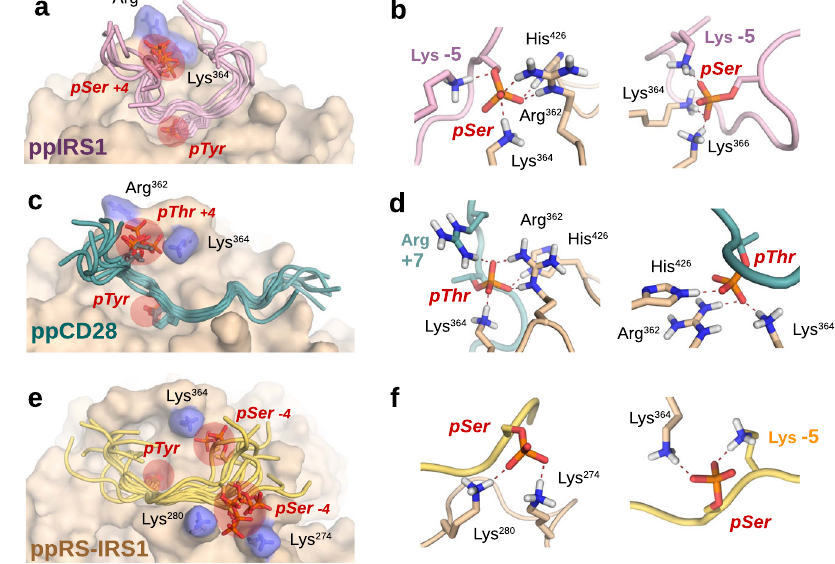
Fig. 5 | Haddock modelling of all three SHP2-substrate complexes. Structural ensembles from the lowest energy HaddockclustersobtainedfortheSHP2-ppIRS1 ( a ), SHP2-ppCD28 ( c ) and SHP2-ppSRev-IRS1 ( e ) complexes after docking a 20- state, structurally diverse input fi le for each structure. The three ensembles are shown from similar angles, providing visibility to the phosphate groups. Residues coloured in blue represent key pSer/pThr coordination points (the two phosphate groups are highlighedinred). PolarH-bondsare drawnas dotted lines on the right panels, detailing two possible phosphate coordination states per complex. a , b In the SHP2-ppIRS1 complex,the pSer residue is typicallycoordinated by theArg362,